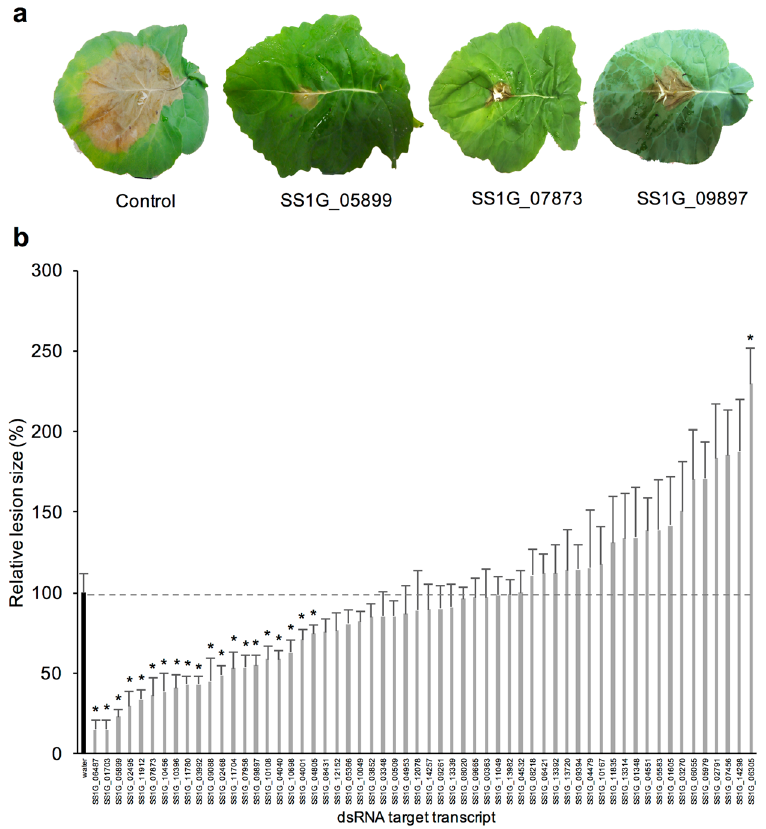
Figure 5. dsRNA targeting S . sclerotiorum suppresses lesion size on B . napus susceptible cultivar Westar ( a ) S . sclerotiorum infection lesions on Brassica napus cv . Westar following a treatment of 200 ng dsRNA targeting S . sclerotiorum genes at 2 dpi. ( b ) Average lesion size (n = 10 leaves) relative to control (black bar) with error bars corresponding to standard error. Significant difference from control represented by asterix ( * )(student’s t-test with Bonferroni correction; p <